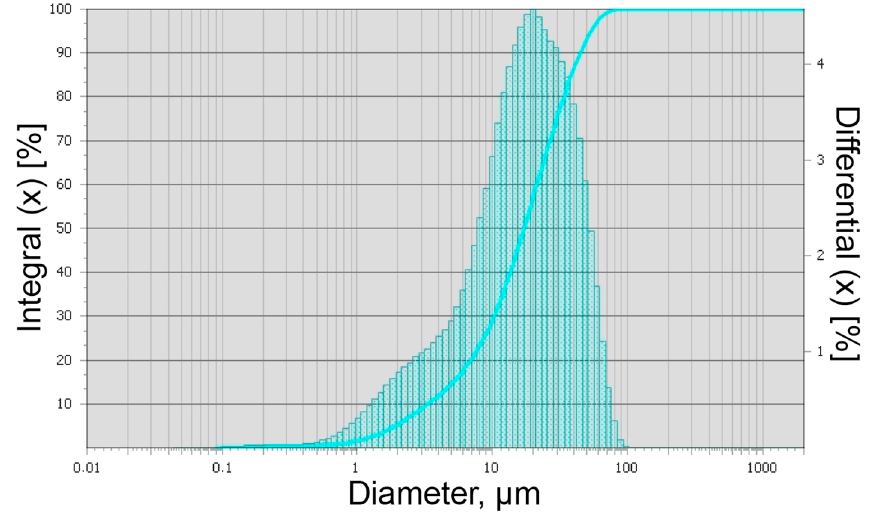
Figure 3. Fractional composition of wheat straw powder .